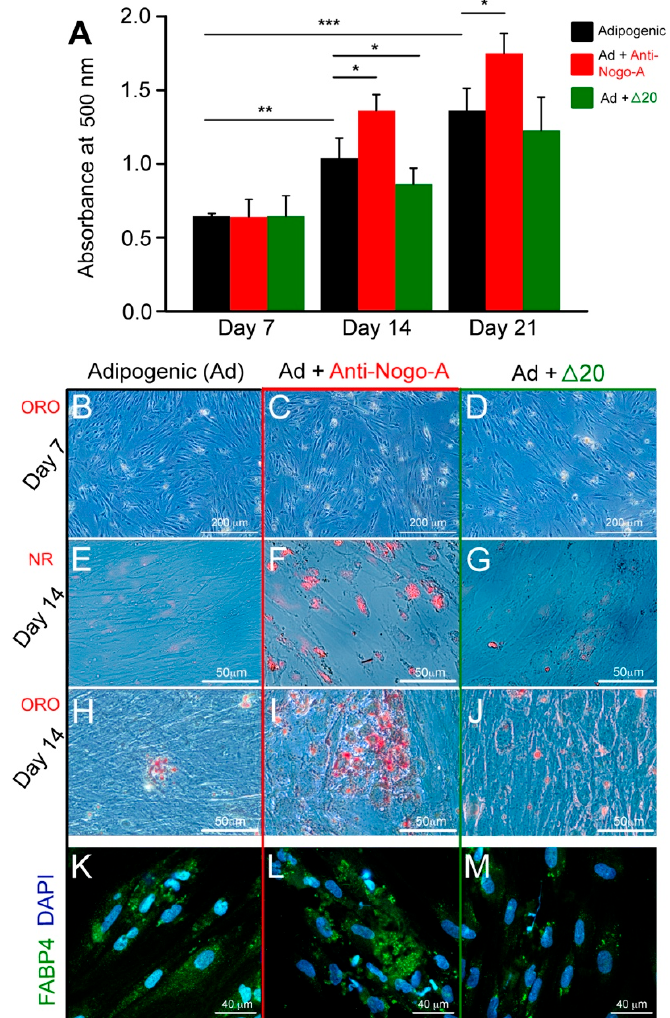
Figure 6. Effects of the Nogo-A protein (Nogo-A ∆ 20 fragment) and anti-Nogo-A antibody on the adipogenic differentiation of hDPSCs. ( A ) Quantification of Oil Red O (ORO) staining in hDPSCs cultured in adipogenic medium (Ad) alone (black colored columns), adipogenic medium supplemented with the anti-Nogo-A antibody (red colored columns), and adipogenic medium supplemented with the Nogo-A ∆ 20 protein (green colored columns) for 7, 14 and 21 days. Four independent biological replicates were used. The bars represent the means ± standard errors. Asterisks above the error bars denote significant differences (*, p < 0.05; **, p < 0.01; ***, p < 0.001) by one-way analysis of variance (ANOVA). ( B – J ) ORO ( B – D , H – J ) and Nile Red (NR) staining ( E – G ) indicating the formation of lipid droplets (red color) in hDPSCs cultured in adipogenic medium alone ( B , E , H ), in adipogenic medium supplemented with the anti-Nogo-A antibody ( C , F , I ), and in adipogenic medium supplemented with the Nogo-A ∆ 20 protein ( D , G , J ) for 7 and 14 days. ( K – M ) Fatty Acid Binding Protein 4 (FABP4) im- munofluorescence staining (green color) in hDPSCs cultured for 21 days in adipogenic medium alone ( K ), in adipogenic medium supplemented with the anti-Nogo-A antibody ( L ), and in adipogenic medium supplemented with the Nogo-A ∆ 20 protein ( M ). DAPI (blue color) marks the nuclei of the cells. Scale bars are as